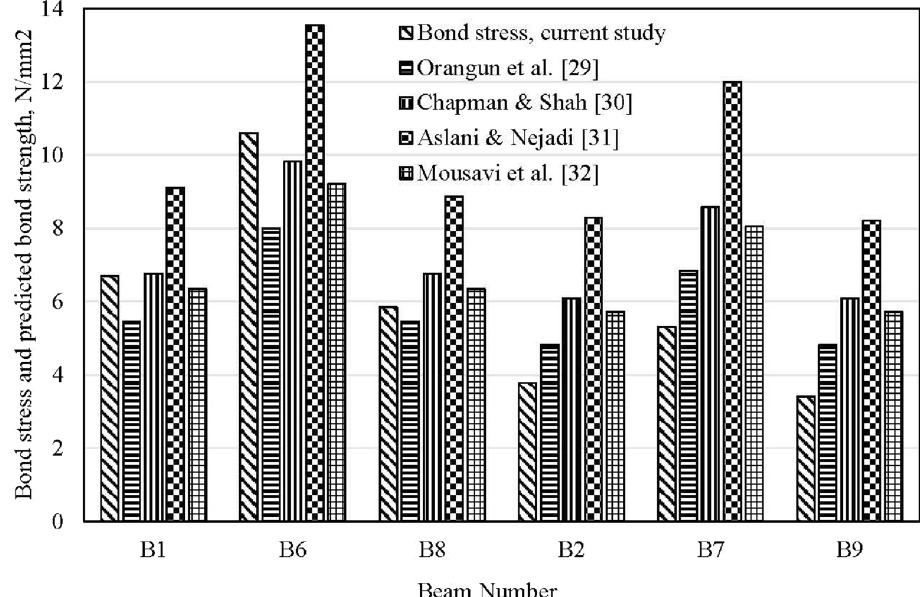
Fig. 23 Bond stress results in the current study and those predicted by other